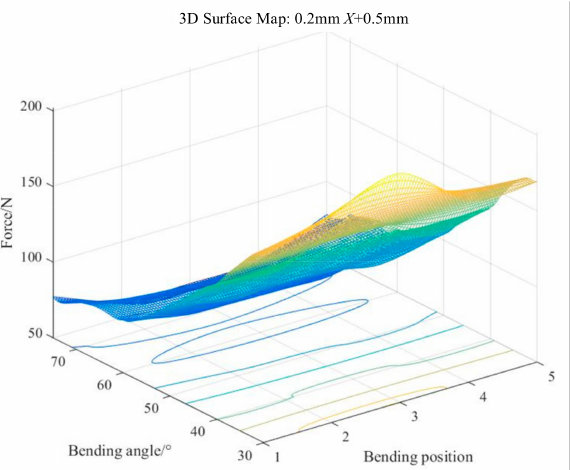
Figure 10. Force required to produce a displacement of 0.5 mm in the X -direction.